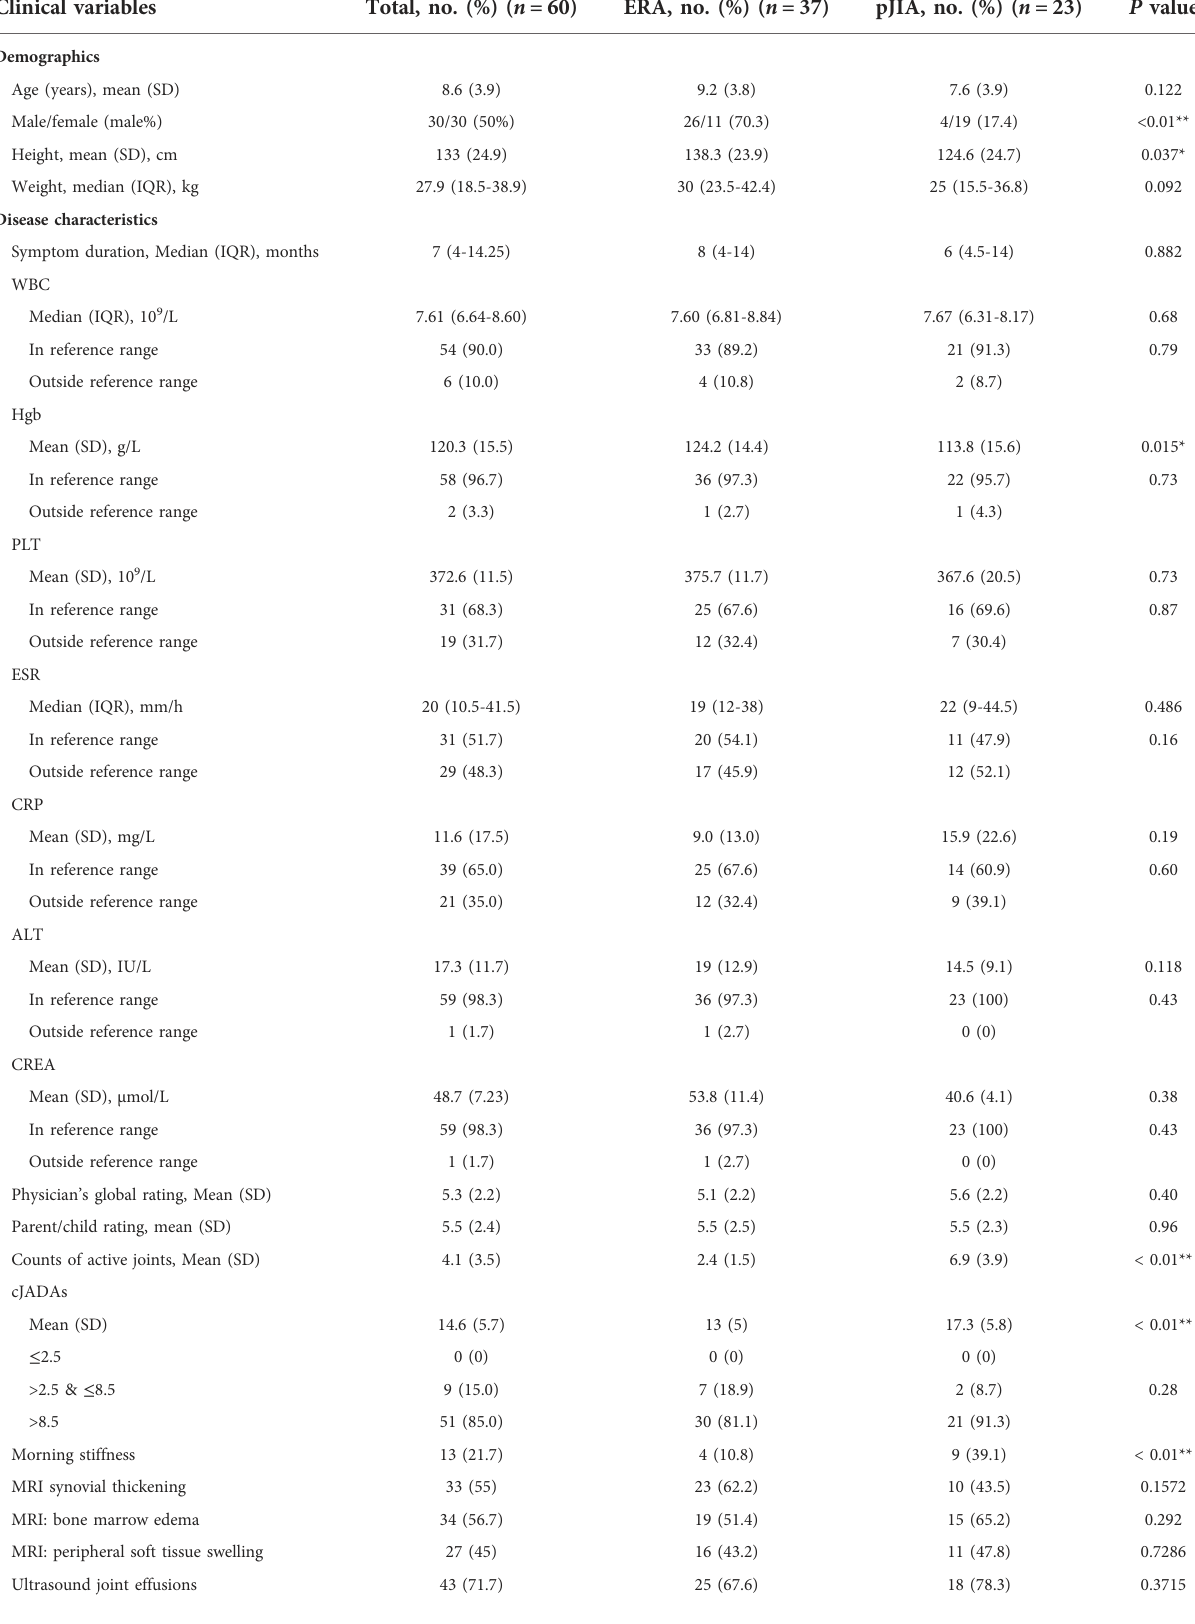
TABLE 1 Clinical characteristics of children with JIA. Clinical